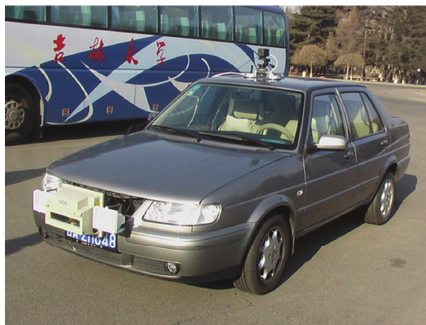
Figure 1: Multisensor based pedestrian recognition experimental